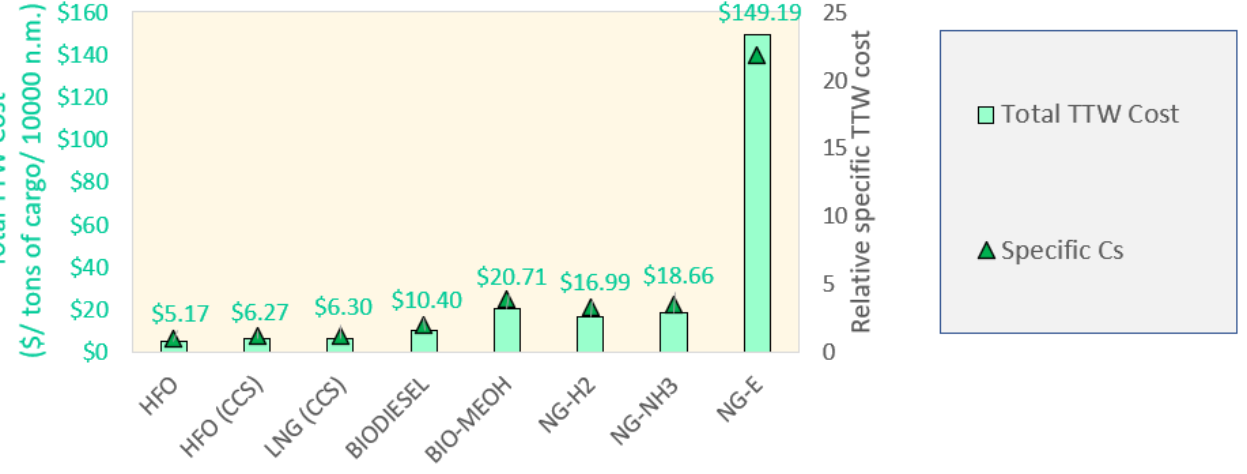
Figure 9. Total cost for transporting 1 ton of cargo for 10,000 nm (columns) and relative C S (triangles) for the various fuels. The reference is an HFO-fuelled containership carrying 1.25 m 3 /ton for 10,000 nm.